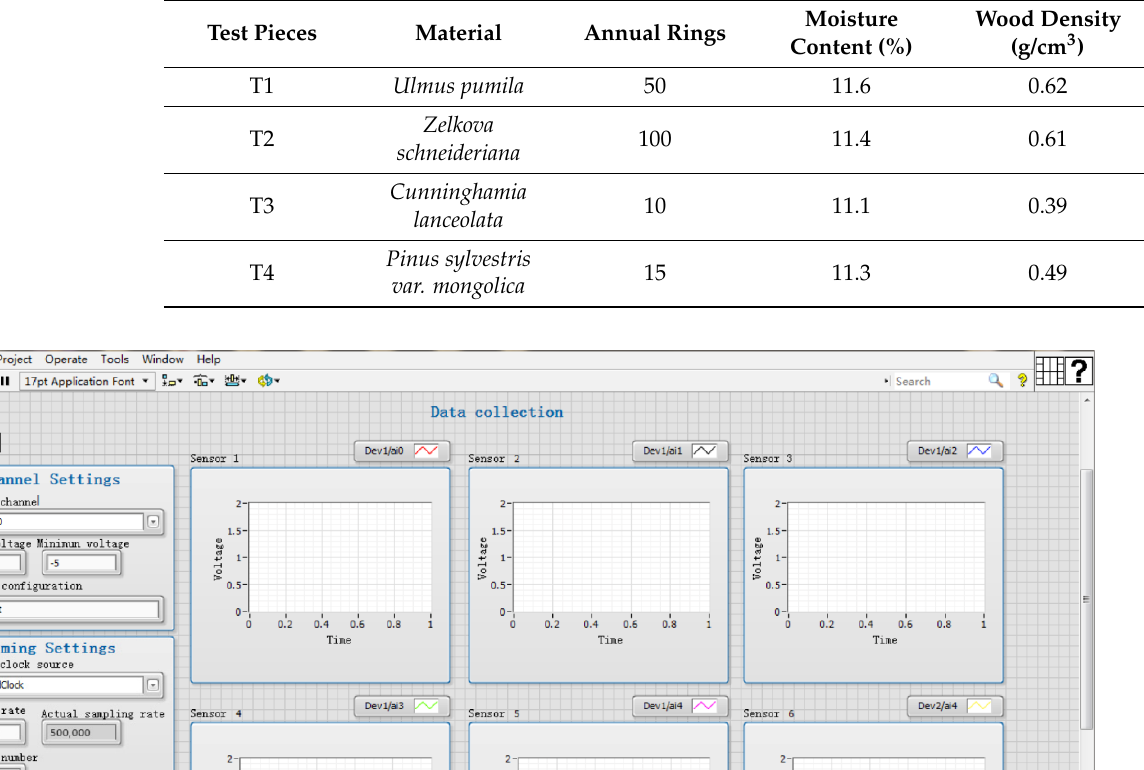
Table 1. Test piece parameters.